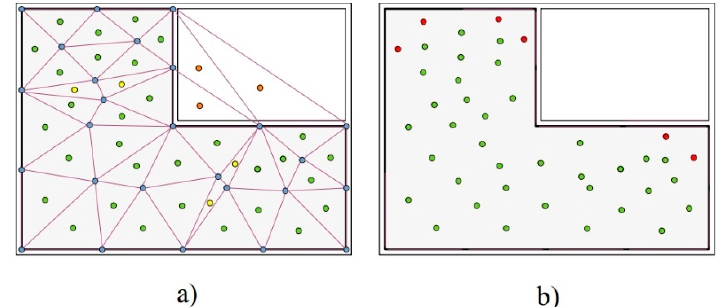
Figure 7. Navigable space is partitioned by applying Delaunay triangulation process. ( a ) Since the polygon that contains navigable space may be concave, some positions obtained after the division can fall out of navigable space (orange). Small triangles are discarded according the parameters l min and α min (yellow). ( b ) A filtering process is conducted to retrieve positions are inside navigable space (points generated by Voronoi process are included). Subsequently, points near obstacles are discarded (red) according to the defined security distance.